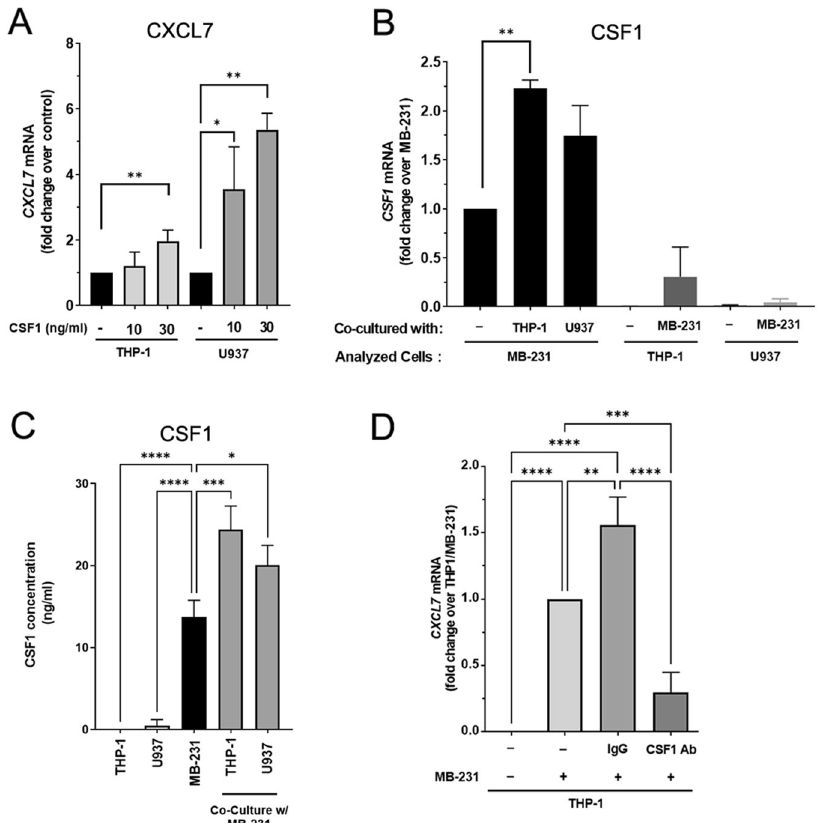
Fig. 2 CSF1 secreted by MDA-MB-231 cells induces CXCL7 expression from THP-1 monocytes. A CXCL7 mRNA expression in the presence of recombinant CSF1. THP-1 or U937 cells were treated with recombinant CSF1 (10 or 30 ng/mL) for 48 h, RNA was then extracted to detect CXCL7 expression. Data represent the normalized means ± SD ( n = 3 biological replicates; * p < 0.05; ** p < 0.01). B CSF1 mRNA expression in MDA-MB-231, THP-1, U937 cells, or MDA-MB-231 cells co-cultured with THP-1 or U937 monocytes for 48 h. RNA was extracted from MDA-MB- 231, THP-1, or U937 cells for analysis as indicated. Data represent the normalized means ± SD ( n = 3 biological replicates; ** p < 0.01). C The CSF1 protein concentration collected from the cultured media of MDA-MB-231, THP-1, U937 cells only or MDA-MB-231 co-cultured with THP-1 or U937 cells for 48 h were determined by ELISA assay. Data represent the means ± SD ( n = 3 biological replicates; * p < 0.05; *** p < 0.001; **** p < 0.0001). D CXCL7 mRNA expression in THP-1 cells co-cultured with MDA-MB-231 cells in the presence of CSF1 neutralizing antibodies (5 μ g/ ml) or equivalent amount of control IgG for 48 h, RNA was extracted to detect CXCL7 expression. The level of CXCL7 mRNA in MDA-MB-231 cells co-cultured with THP-1 monocytes was used as a control. Data represent the normalized means ± SD ( n = 3 biological replicates; ** p < 0.01; *** p < 0.001; **** p <